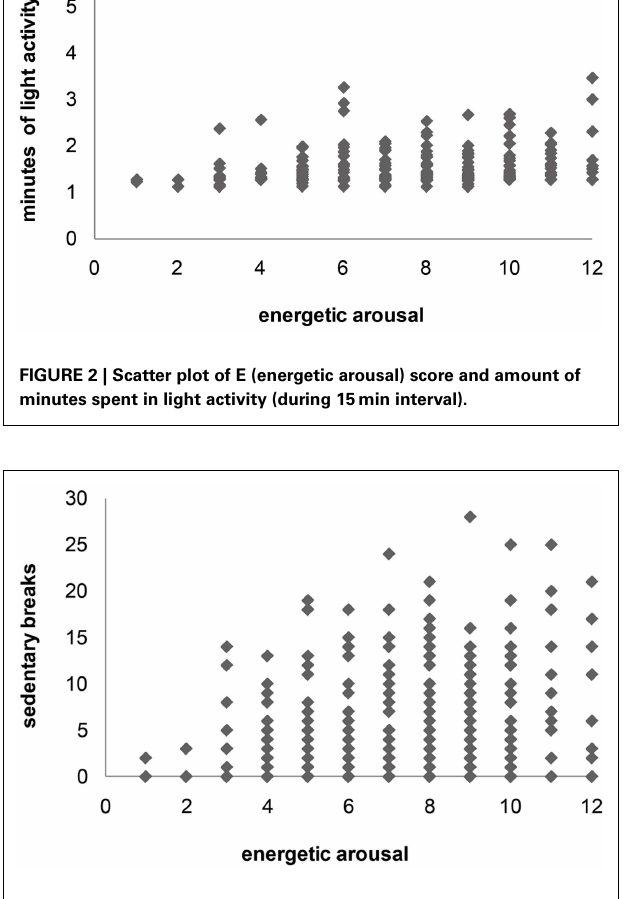
FIGURE 3 | Scatter plot of E (energetic arousal) score and sedentary breaks (during 30min